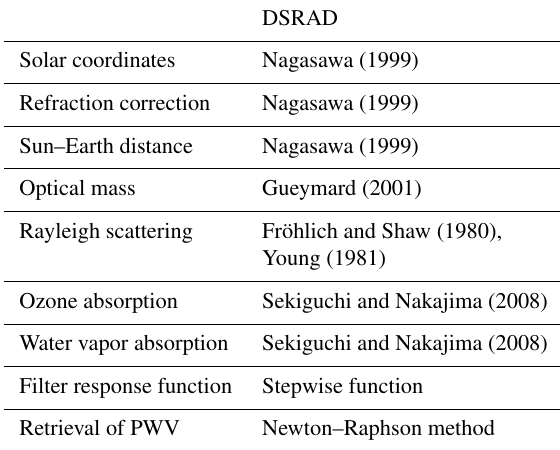
Table 4. References and methodologies of the DSRAD